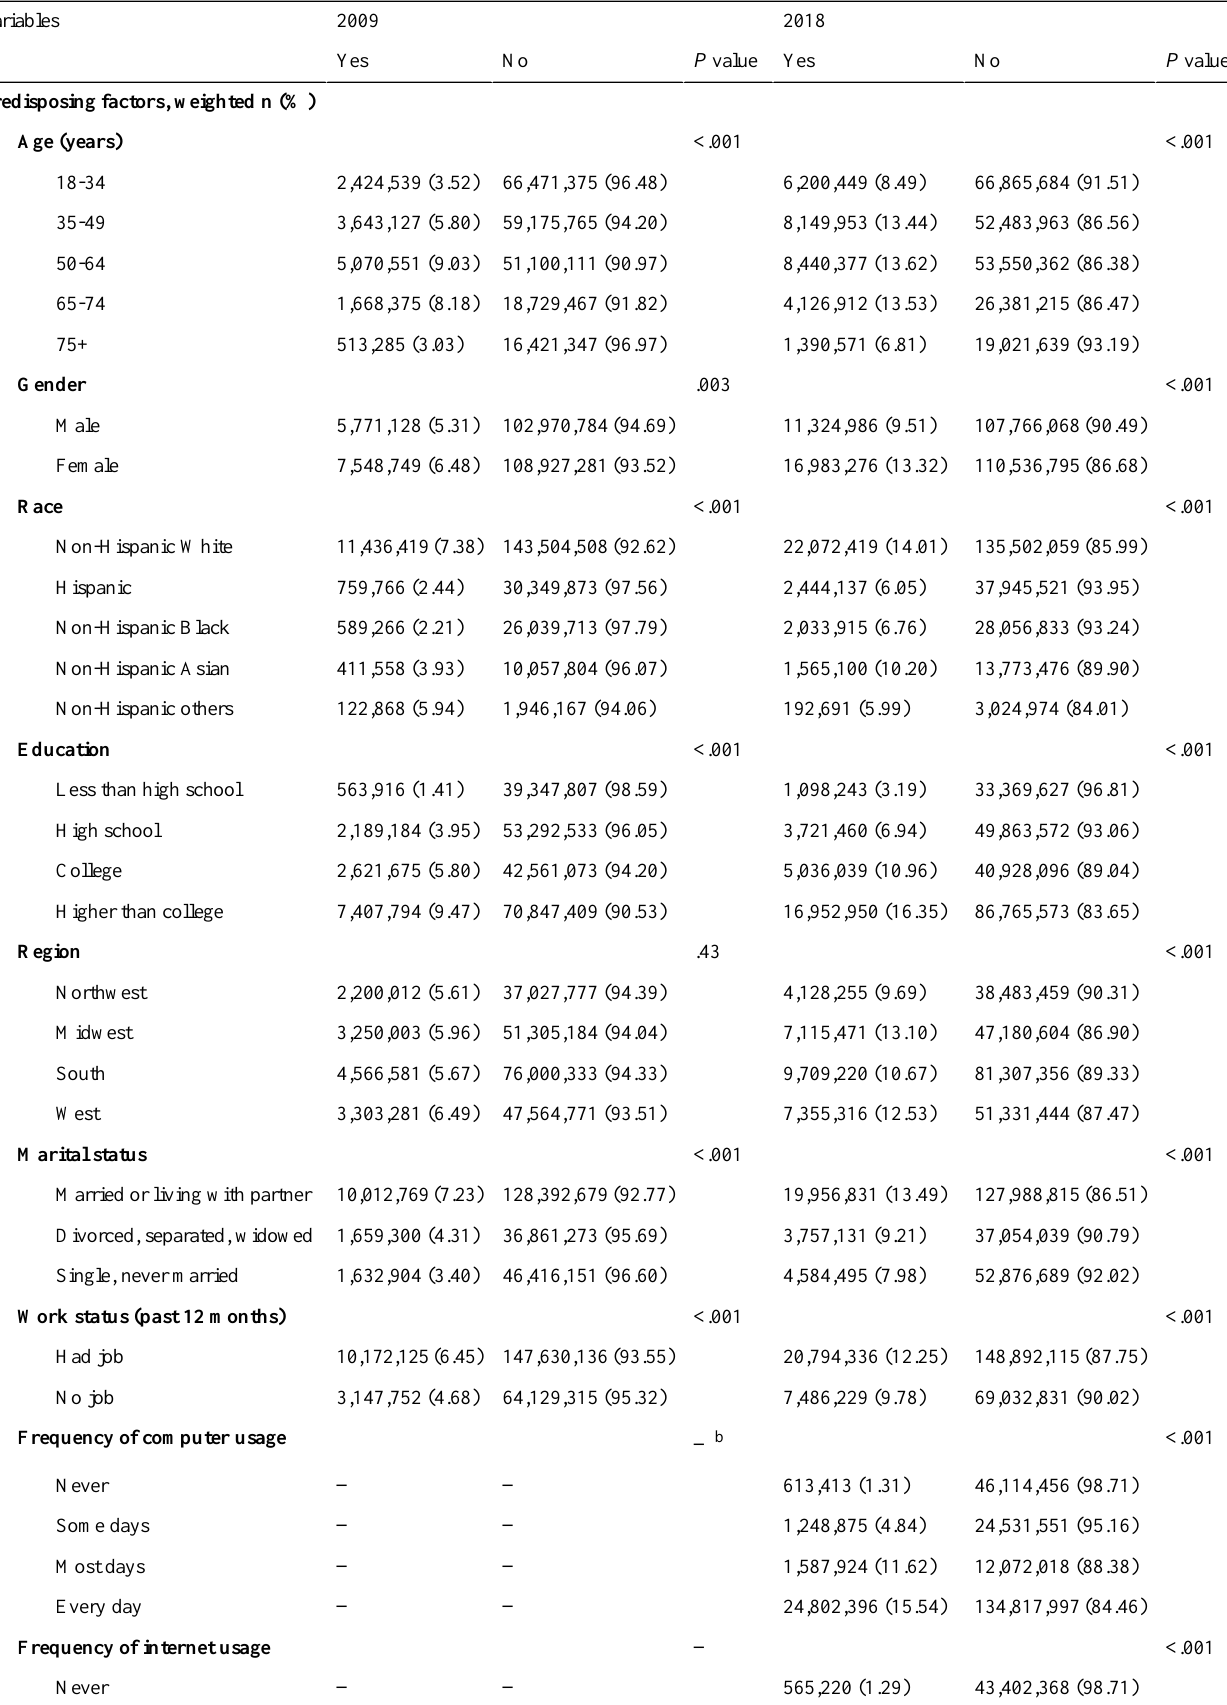
Table 1. Characteristics and a comparison between web-based prescription fillers and nonfillers in the past 12 months during the survey year: weighted statistics in 2009 (n=1489; N=13,319,877) a and 2018 (n=2892; N=28,308,262) a